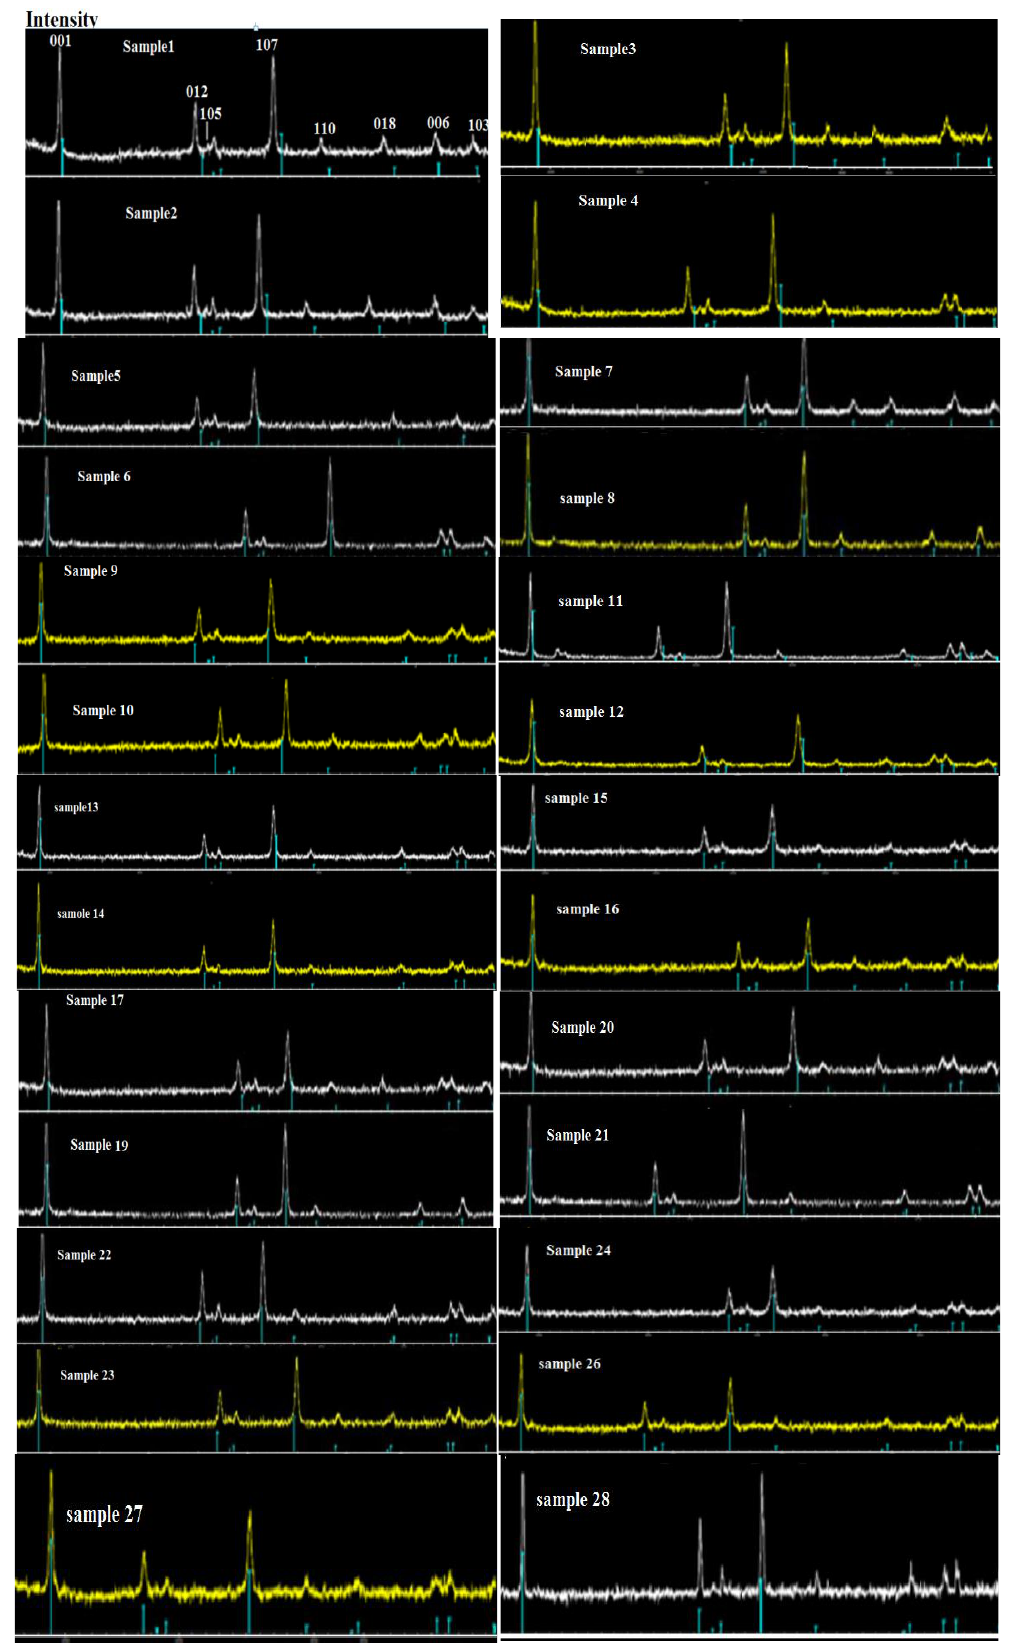
Figure 5. XRD plots of samples 1 – 28 from the current system.